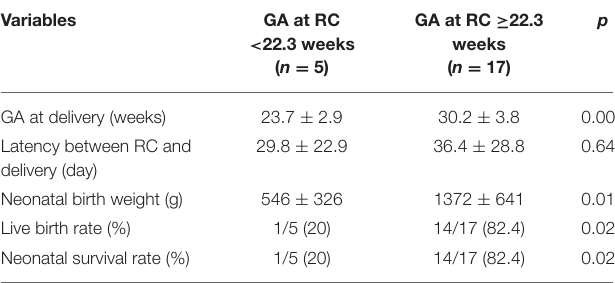
TABLE 3 | Comparison of pregnancy outcomes among patients with singleton pregnancies according to GA at RC.